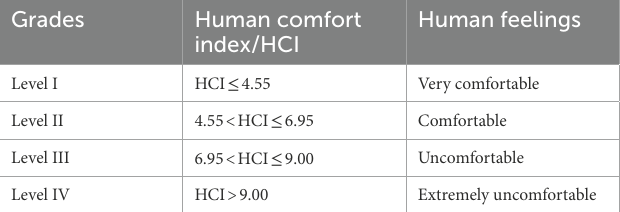
TABLE 3 Evaluation criteria for human comfort index.